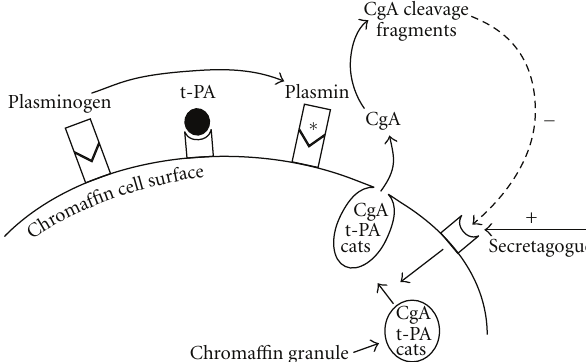
Figure 5: Working model for a local (autocrine/paracrine) chro- ma ffi n cell plasminogen/plasmin system and its interactions with CgA. Upon stimulation of the chroma ffi n cell by a secretagogue, CgA and catecholamines (cats) are coreleased by exocytosis. Plasminogen (from circulating sources) and its activator t-PA (synthesized and secreted from the chroma ffi n cell) bind to the chroma ffi n cell surface, with resultant activation of plasminogen to plasmin. CgA subsequently is cleaved by plasmin to liberate peptide fragments, which provides a negative feedback loop to modulate subsequent catecholamine release.